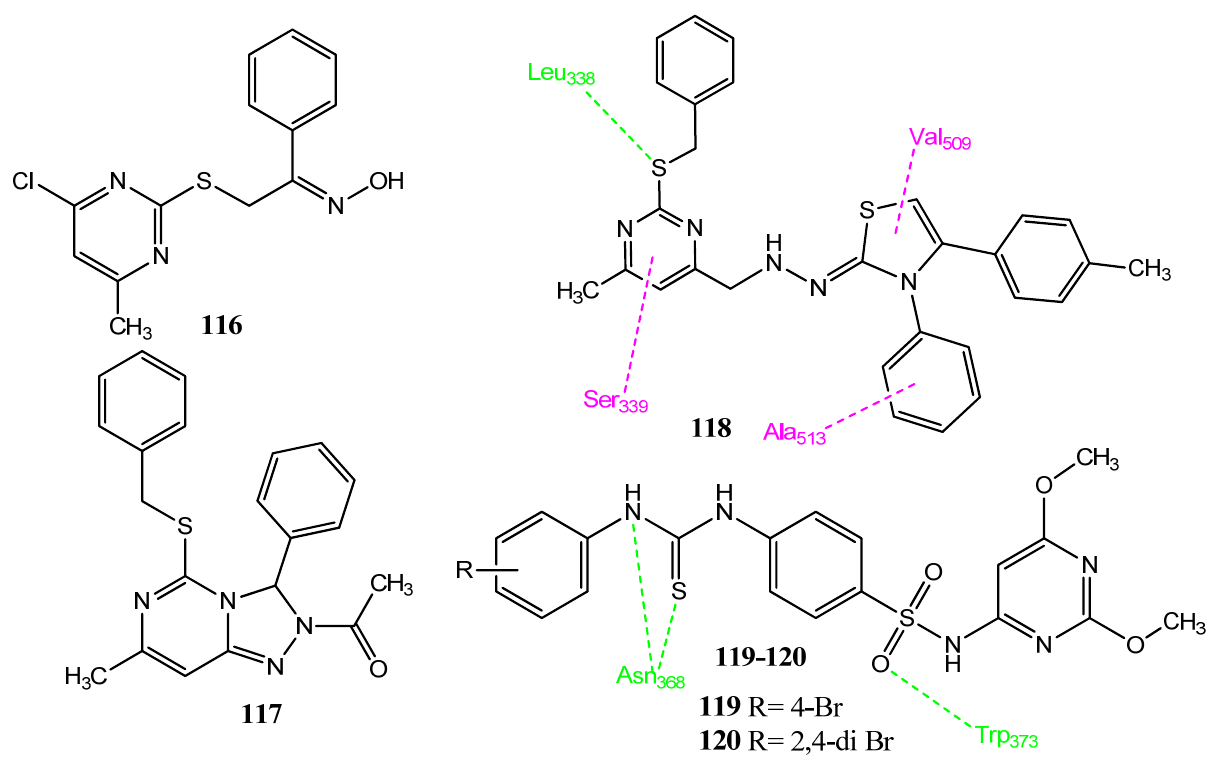
Figure 23. Heterocyclic